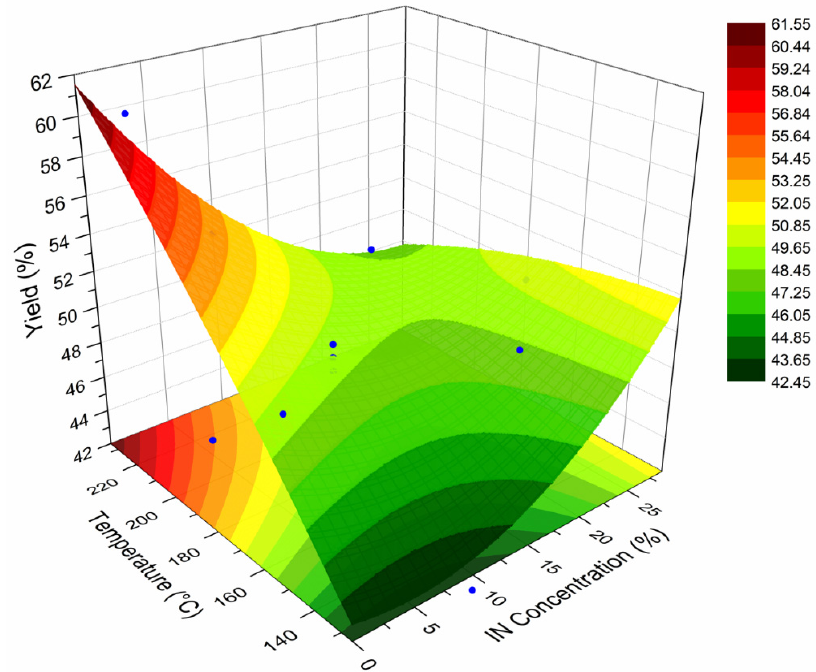
Figure 6. SRP for the yield of the spray-dried powders containing the active ingredients (INMX_1–